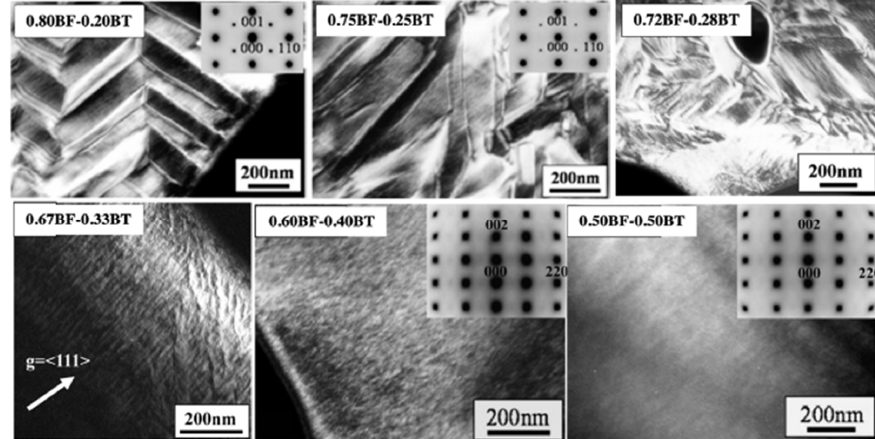
Figure 10. Domain structure of BiFeO 3 –BaTiO 3 system as a function of BaTiO 3 contents. Reprinted with the permission of [76]. Copyright © 2008 Taylor & Francis. Reprinted with the permission of [92]. Copyright © 2009 Taylor & Francis.